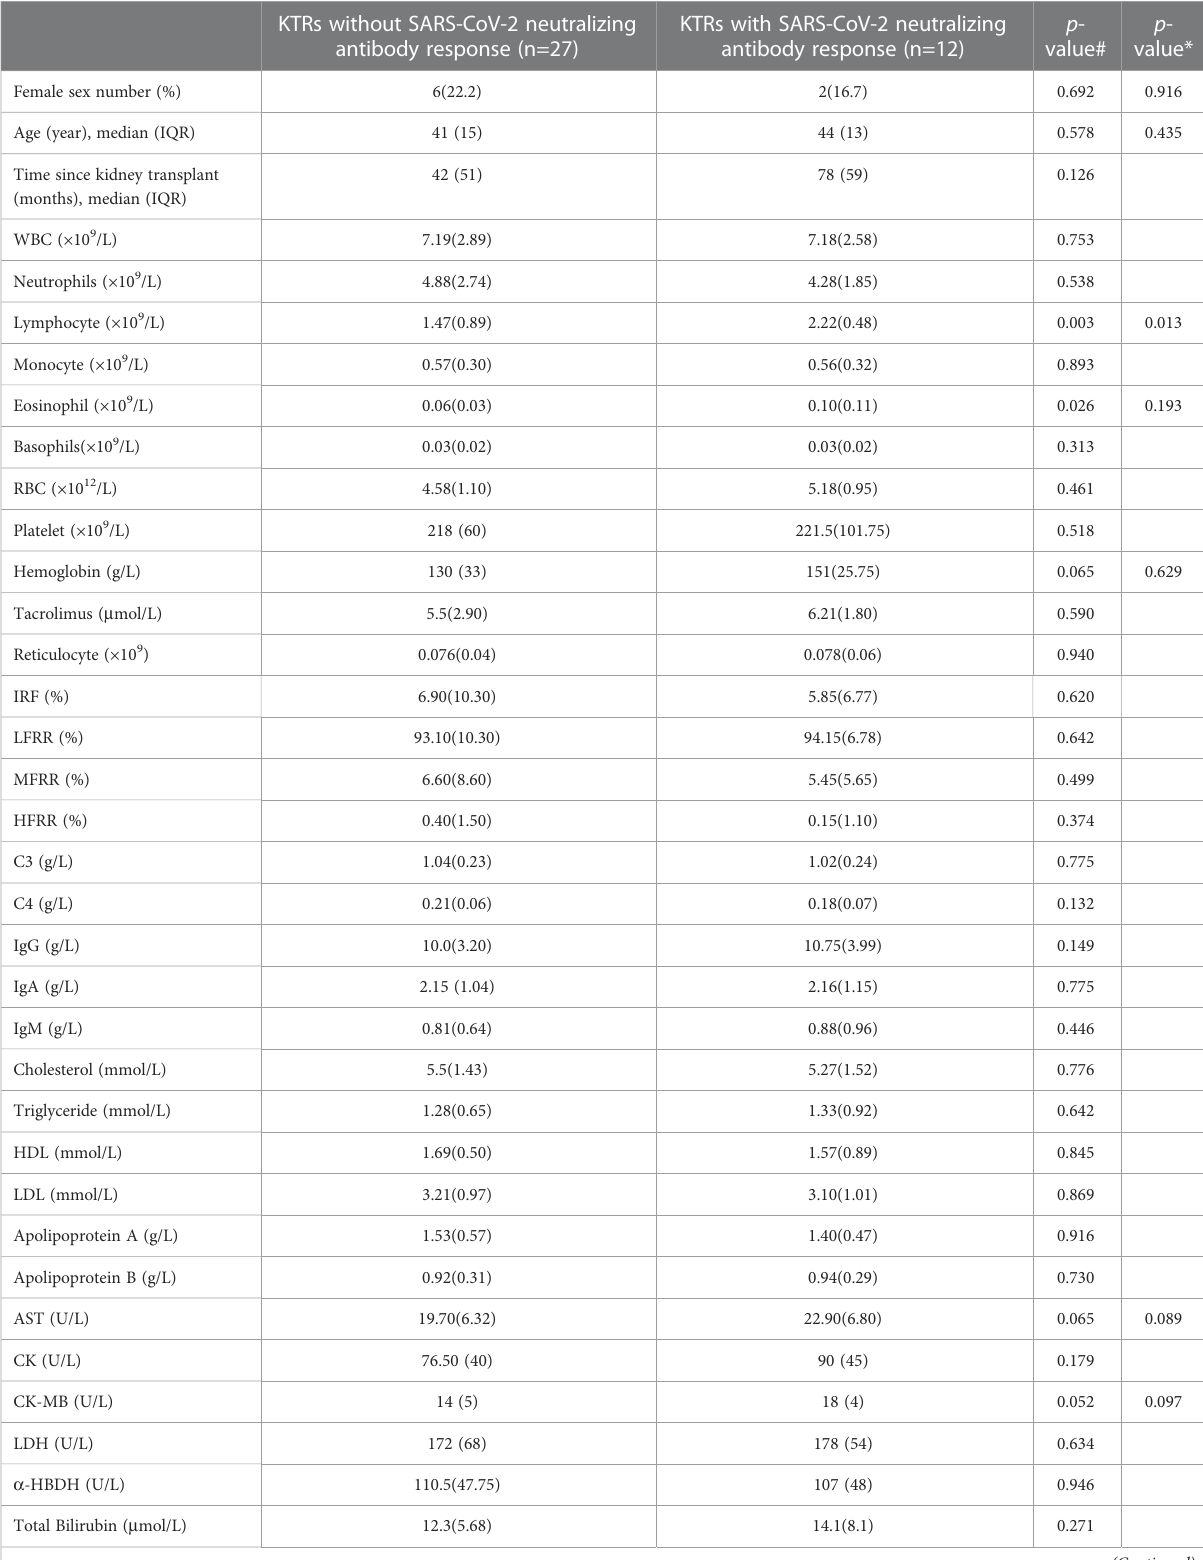
TABLE 2 Comparative analysis of the pre-boosted demographic characteristics and clinical laboratory parameters between kidney transplant recipients with and without SARS-CoV-2 speci fi c neutralizing antibody response after homologous inactivated vaccine